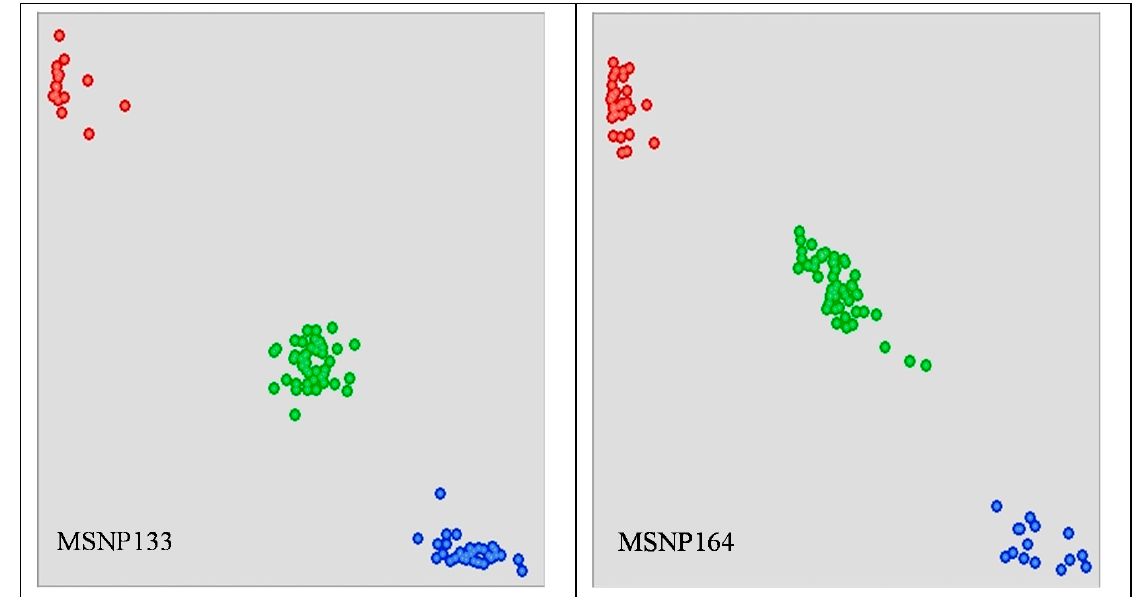
Figure 1. Genotyping patterns of MSNP133 and MSNP164 markers on kompetitive allele-specific polymerase chain reaction (KASP) assay. Each solid dot is an actual genotype of a sample at the SNP marker. The coordinate position of each dot is obtained by calculating the fluorescence signal values of the two alleles. The data points of the same genotype gather together, and the heterozygous genotype points are between the two homozygous genotypes. The green points represent heterozygous genotype, the red and blue points represent two homozygous genotypes.